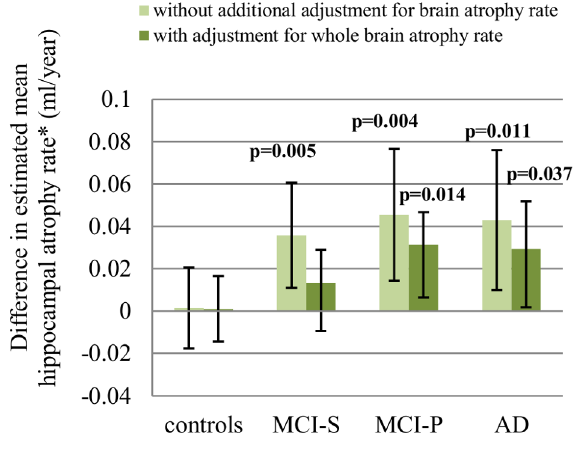
Figure 5. Difference in hippocampal atrophy rates*: e 4 + vs e 4-.